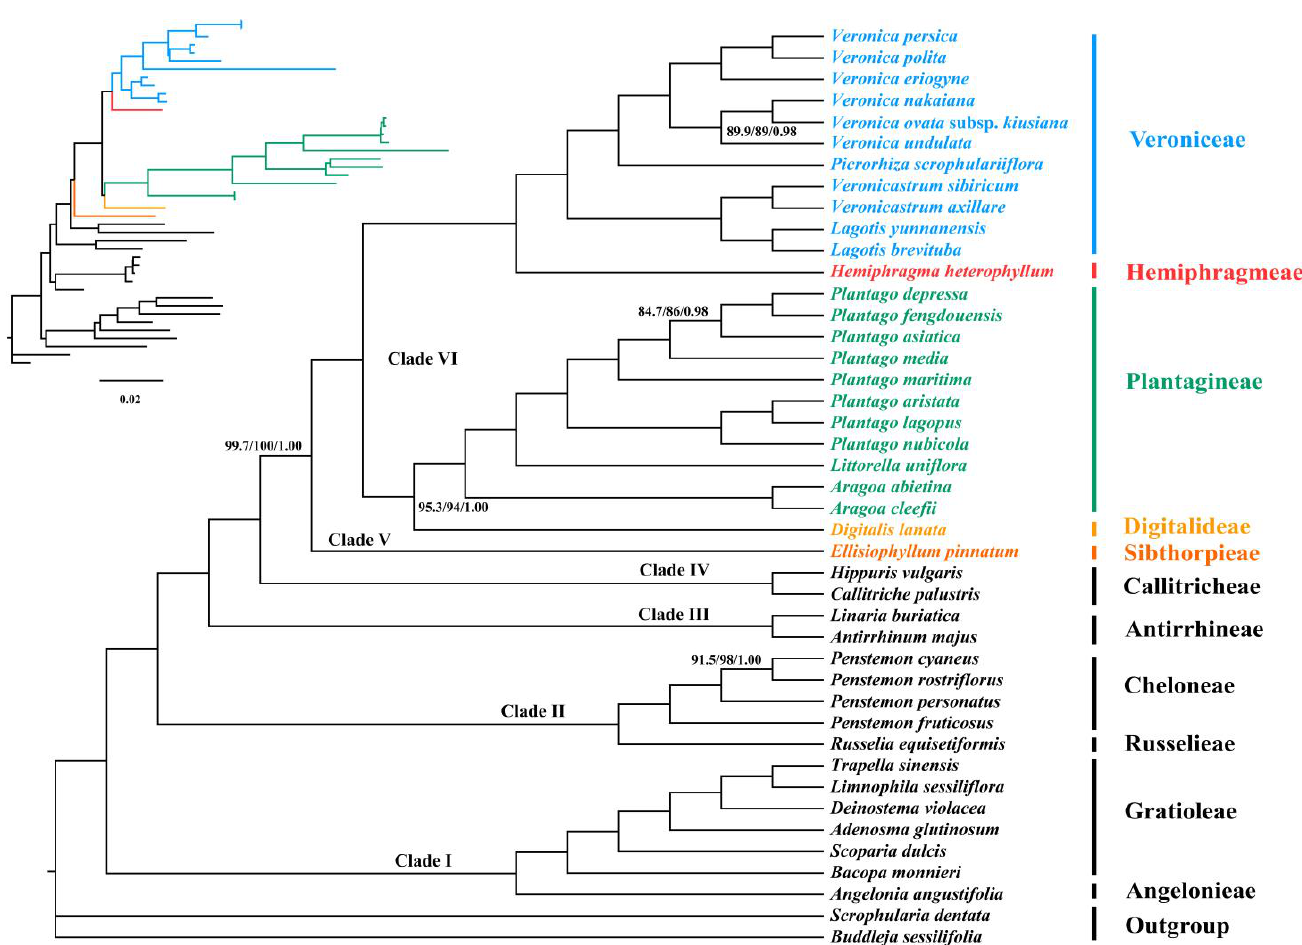
Figure 4. Phylogeny of Plantaginaceae reconstructed by analyses of 68 concatenated plastid PCGs using maximum likelihood (ML) and Bayesian inference (BI) methods. Values at nodes represent the ultrafast bootstrap support values (UFBoot) and SH-aLRT values (SH-aLRT) of the maximum likelihood analysis and the posterior probabilities (PP) of the BI analysis values. All unlabeled nodes indicate high support values (UFBoot = 100; SH-aLRT = 100; PP = 1.00). Despite slight differences in some relationships observed within Veronica and Penstemon, the species tree topology implemented in ASTRAL was basically congruent with the result of the concatenation analyses, with high local posterior probability (LPP) values at most nodes (Figure 5). Notably, support values at the nodes of Digitalideae + Plantagineae (LPP = 0.7) and Russelieae + Cheloneae (LPP = 0.78) were relatively low, while the location of Sibthorpieae (LPP = 0.87) was only moderately supported.